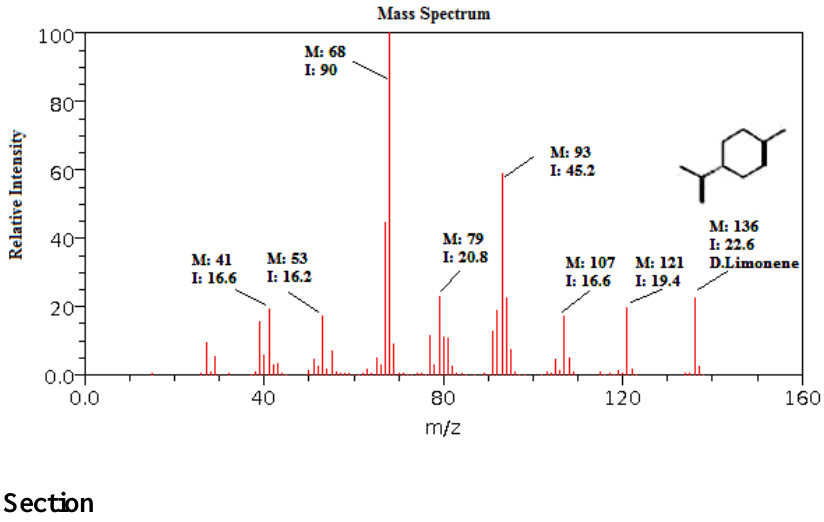
Figure 6. Mass spectrum of the main volatile compound produced by Bga ICMP11096, a cyclic terpene (an isomer of limonene